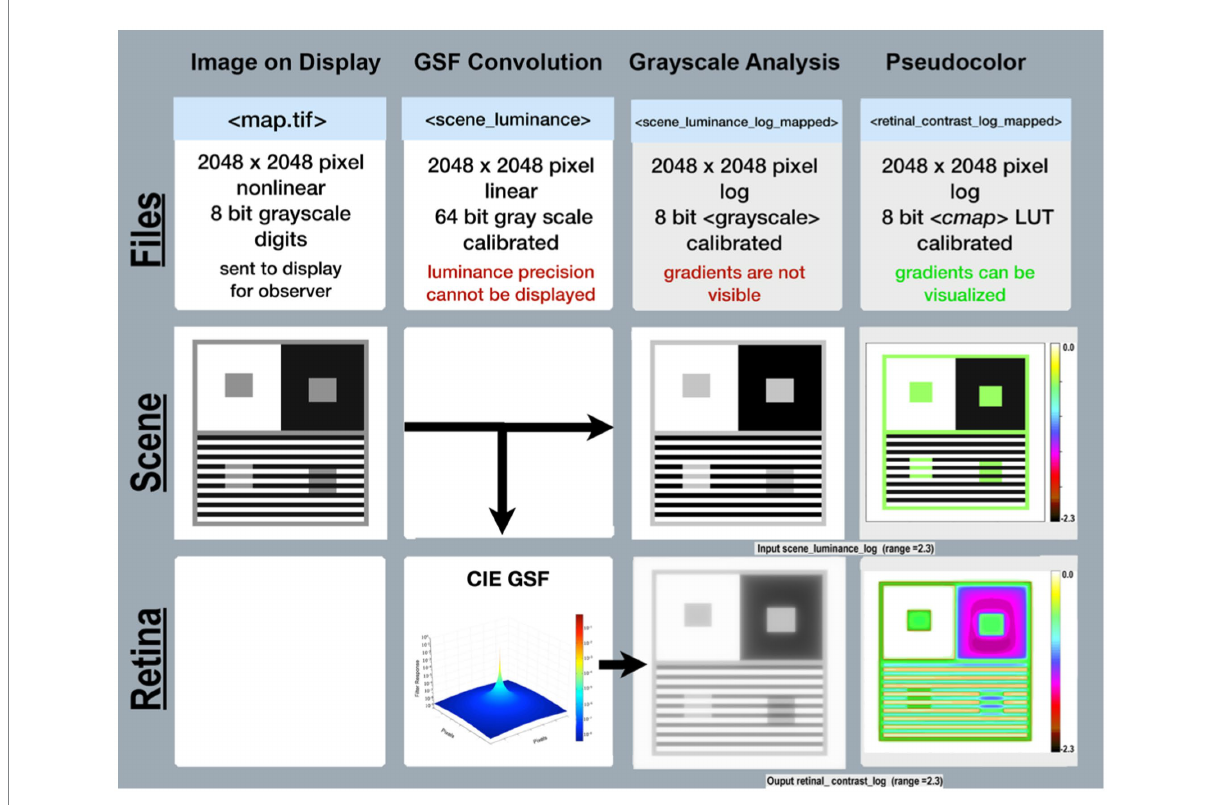
FIGURE 3 Required data for calculating < retinal_contrast> , and analyzing the effects of glare. Columns illustrate the sequential steps in < test_retinal_ contrast.py> : Image on Display; GSF Convolution; Grayscale and Pseudocolor Analysis. Rows identify the Files; Scenes; and Retina. Files-(top-row) identifies the names, specifications, and precisions at each step. The terms nonlinear, linear, and log refer to plots of cd/m 2 vs. digit value in the images. The measured luminances from the display were a nonlinear function of Photoshop digits. The program’s calibration step made < scene_ luminance > linear for the convolution. The analysis of glare used [log_range = 2.3]. Scene-(middle row) illustrates the appearance of the image on the display in the first column; the CIE GSF convolution in the second; the normalized cd/m 2 input image in the third; and the Pseudocolor visuization of the uniform luminance patches in the fourth column. Note the Color-bar on the right side of this image scene. It plots all 256 pseudocolor samples and identifies the [ log_range ] of the image. Max luminance is White with [ scene_luminance_log = 0.0] while Min luminance is Black with [ scene_luminance_log = − 2.3]. This Color-bar links the RGB digit values to log luminances. Note that all Gray pixels in Scene(Pseudocolor) have the same Color-bar visualization (green RGB triplet [192, 255, 64]). That triplet is the Pseudocolor output for all grayscale digits in the scene from digit 194 to 197, that calibrates to a log scene luminances range between − 0.52 and − 0.55. Each Color-band is traceable to log luminance cd/m 2 values. The second column in Retina-(bottom-row) shows a Pseudocolor 3D plot of convolution kernel for the CIE GSF. The third column shows the grayscale log retinal contrast image used to provide calibrated data for plots, and numerical analysis of < retinal_ contrast > image segments. The fourth column shows the Pseudocolor image used for visual inspection of the spatial pattern of gradients. Gradients are not visible in grayscale images, but are clearly observed in Pseudocolor. Note Contrast’s large Black surround for the ROI in the third column. Compare it with the Pseudocolor’s visualization of in the fourth column. Peudocolor’s bands of colors reveal the magnitude, and complexity of glare’s